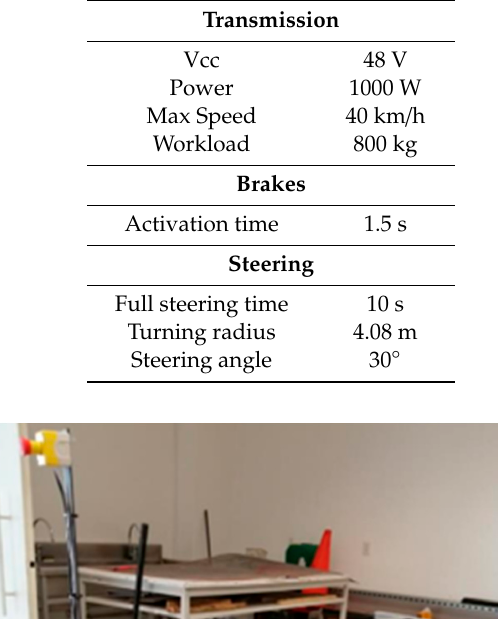
Table 3. Modular vehicle platform technical characteristics.